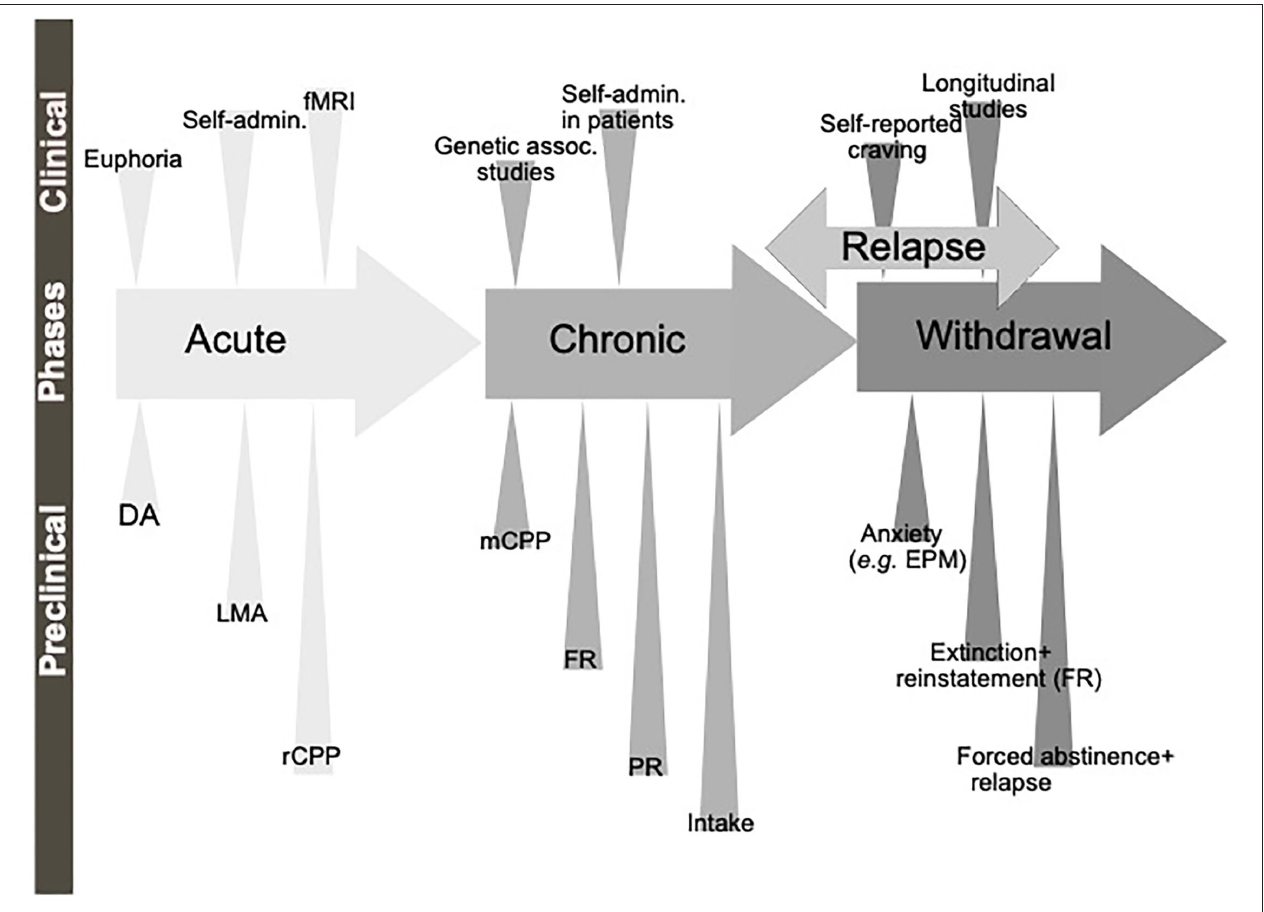
FIGURE 1 | Schematic illustration of the different phases of the addiction cycle. Alcohol or drugs of abuse when consumed acutely can be modeled both in animals (preclinical) and humans (clinical models). Similarly, when exposed for longer periods of time other models can be applied. During withdrawal and relapse other behaviors are evident. Dopamine release in nucleus accumbens (DA), locomotor stimulation (LMA), reward of conditioned place preference (rCPP), memory of alcohol reward in the CPP test (mCPP), motivation (FR, and PR), Alcohol and drug intake (Intake), functional magnetic resonance